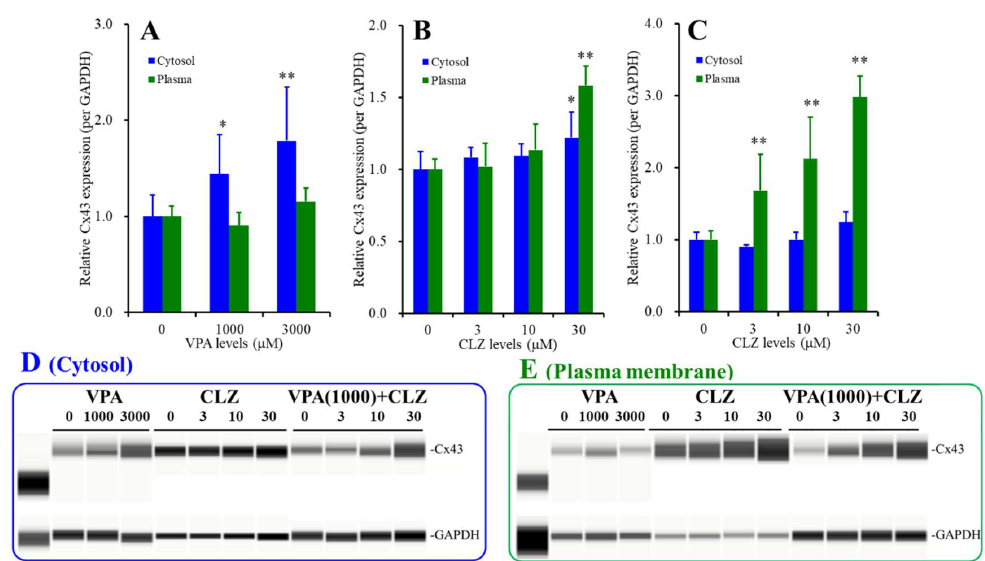
Figure 6. Subchronic e ff ects of VPA (1000 and 3000 µ M) ( A ) and CLZ (3, 10, and 30 µ M) ( B ) on Cx43 expression in cytosol (blue columns) and plasma membrane (green columns) of astrocytes. Acute e ff ects of CLZ (3, 10, and 30 µ M) on Cx43 expression in cytosol and plasma membrane of subchronically treated astrocytes with therapeutic-relevant concentration of VPA (1000 µ M) ( C ). Ordinate: mean ± SD ( n = 6) of relative protein level of Cx43. Abscissa: concentration of VPA and CLZ ( µ M). * p < 0.05 and ** p < 0.01 vs. agent free by MANOVA with Tukey’s post hoc test. Panels 6( D ) and 6( E ) pseudo-gel images using Simple Western results using anti-GAPDH and anti-Cx43 antibody for blotting of cytosol and plasma membrane fractions, respectively.